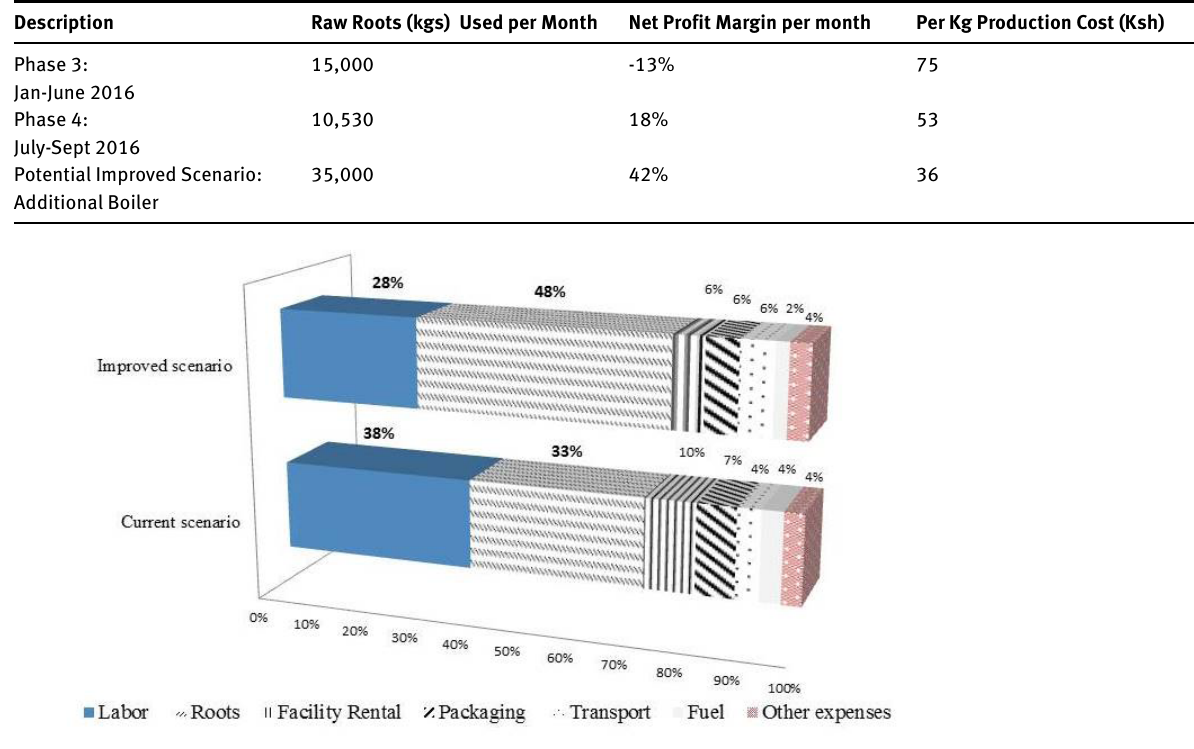
Figure 2: Component costs of OFSP purée production for Phase 4 (current) and with the additional of a second